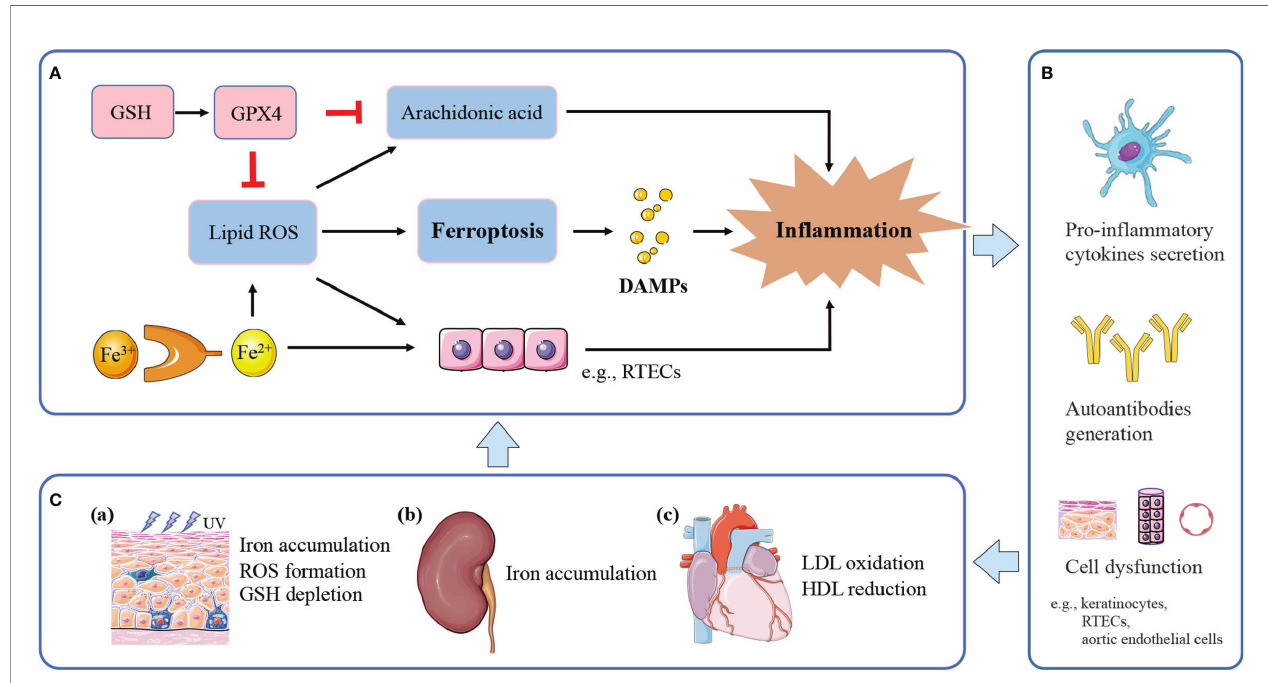
FIGURE 2 | The potential model of ferroptosis in lupus in fl ammation and manifestations. (A) Ferroptosis releases DAMPs to trigger in fl ammation. Iron and ROS accumulation promote a pro-in fl ammatory environment. Massive lipid ROS released by ferroptosis helps to convert arachidonic acid to in fl ammatory mediators. GPX4 suppresses in fl ammation by inhibiting arachidonic acid oxidation and lipid peroxidation. (B) Ferroptotic cell death and induced in fl ammation exert causative effects in SLE through pro-in fl ammatory cytokines secretion, and autoantibodies generation, fi nally leading to cell dysfunction and tissue damage. (C) (a) In fl ammation induced by UV irradiation ampli fi es in fl ammatory and immune responses, eventually causing cutaneous lesions. UVB-exposed skin lesions exhibit iron accumulation, excessive ROS and GSH depletion, leading to keratinocytes ferroptosis. (b) Persistent in fl ammation and immune complexes deposition accelerate lupus progression to renal failure. Kidneys uptake excessive iron in the renal tubules and undergo ferroptosis under pathological conditions. (c) Lipid peroxidation and induced in fl ammation contribute to endothelial dysfunction and cardiovascular injury. Lupus patients with progressive atherosclerosis show decreased HDL and increased oxLDL, which may further promote ferroptosis in aortic endothelial